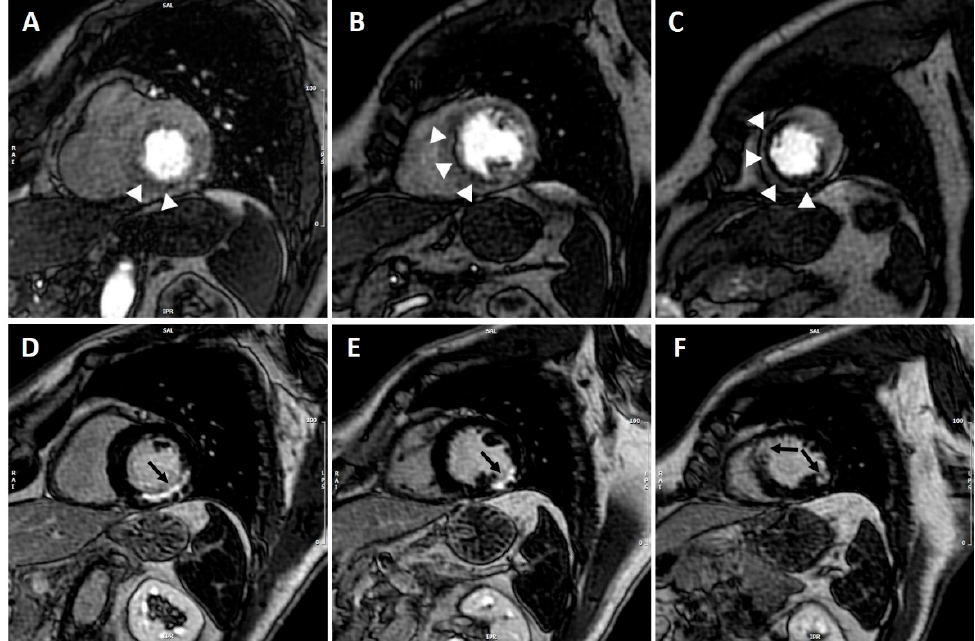
Figure 1. CMR adenosine-stress perfusion in a 60-year-old patient with previous history of myocar- dial infarction. Short axis stress perfusion images at the basal ( A ), mid-ventricular ( B ), and apical ( C ) level. There is evidence of extensive inducible perfusion defect of the basal infero-septum and infe- rior wall, mid-cavity septum and apical anterior, and inferior and septal walls (white arrow-heads). Corresponding LGE images ( D – F ) show almost transmural LGE involving the basal inferior and infero-lateral walls, the mid-cavity infero-lateral wall, and the apical antero-septum and infero-lateral wall (black arrows). CMR findings were consistent with transmural myocardial infarction in the left circumflex territory with extensive inducible ischemia in the LAD territory; coronary angiography demonstrated critical proximal LAD